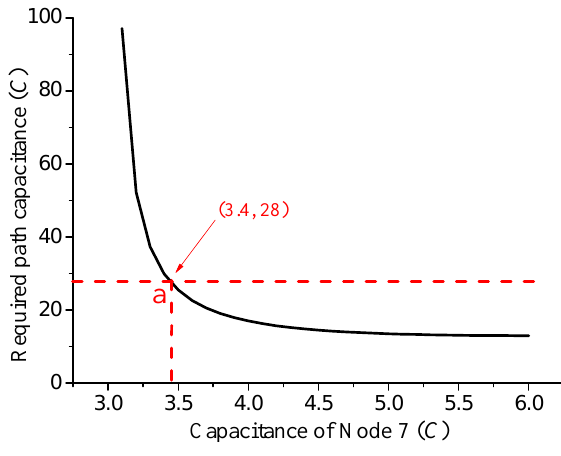
Figure 8. Capacitance of Node 7 vs. required path